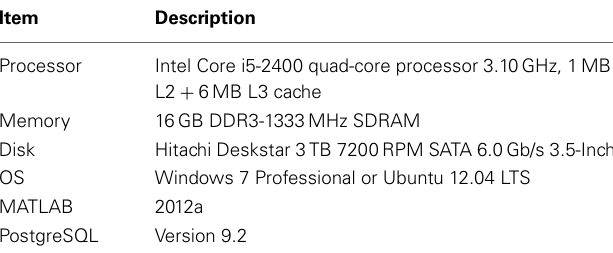
Table 3 | Configuration of test machines for performance tests. Table 4 | MOBBED performance in time in seconds averaged over the datasets within each